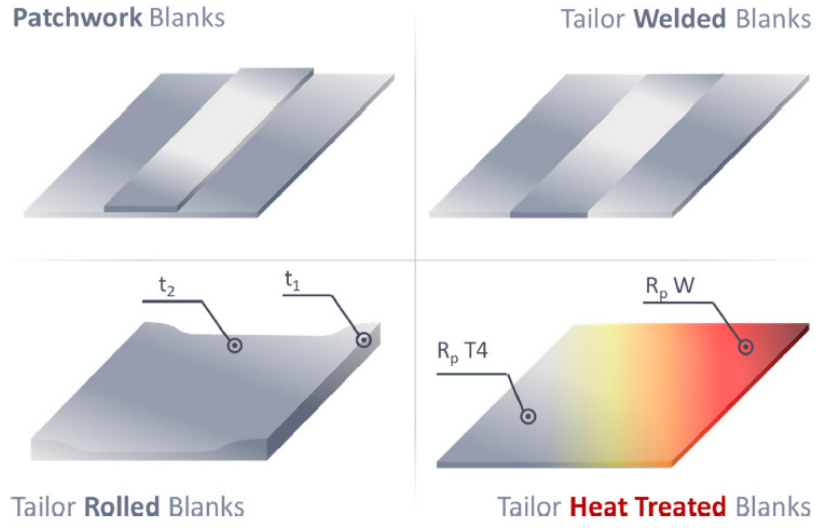
Figure 1. Classification of tailored blanks. Reprinted with permission from Ref. [12]. Copyright 2014, Elsevier.